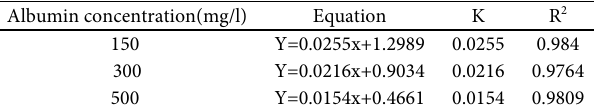
Table 1. Results of the kinetic study of albumin